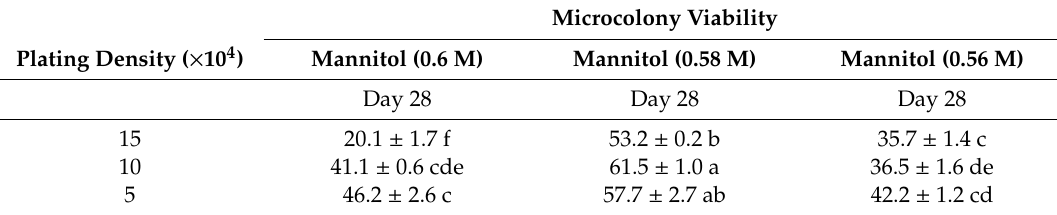
Table 1. E ff ect of plating density and osmoticum condition on microcolony viability after 28 days in liquid culture.